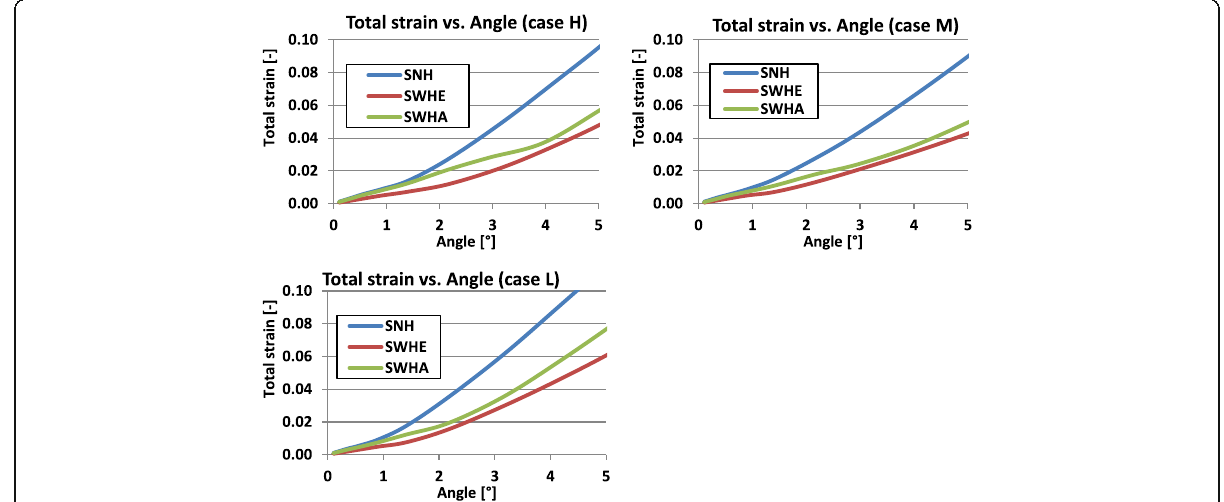
Fig. 20 Total strain versus opening angle calculated with nonlinear 3D FEA: The total strain increased faster for the specimen with no hole (SNH)